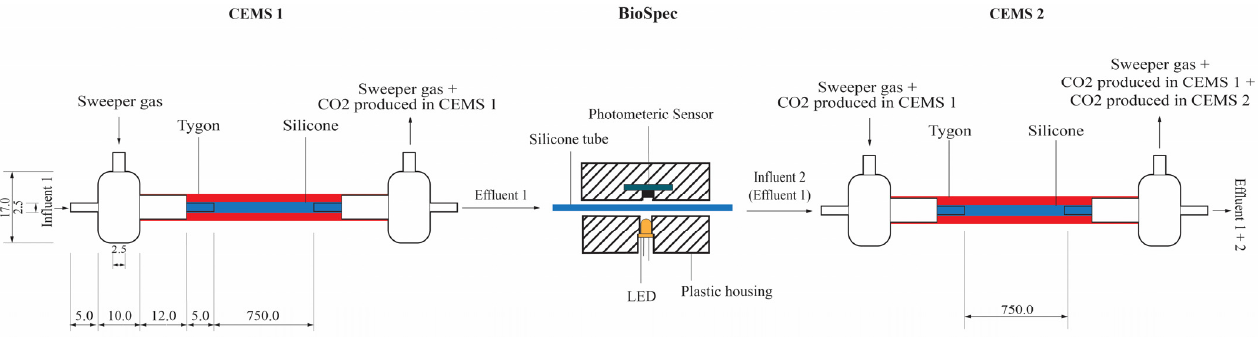
Figure 1. Schematic of the CEMS-BioSpec system used for the real-time monitoring of biofilm parameters under continuous flow conditions. The CO 2 -free sweeper gas is introduced under controlled flow into the annular space of CEMS (red shaded region), allowing for the collection of biofilm-evolved CO 2 and subsequent analysis by a downstream infrared CO 2 analyzer. Biofilm biomass was measured between the two CEMS units (BioSpec) via the internal silicone tube (blue shaded region, containing biofilm biomass) being passed through a cavity with a LED illuminating the tube from one side and a digital light sensor on the transverse side measuring the amount of illumination absorbed by biomass in the tube. All dimensions are to the nearest mm [20].